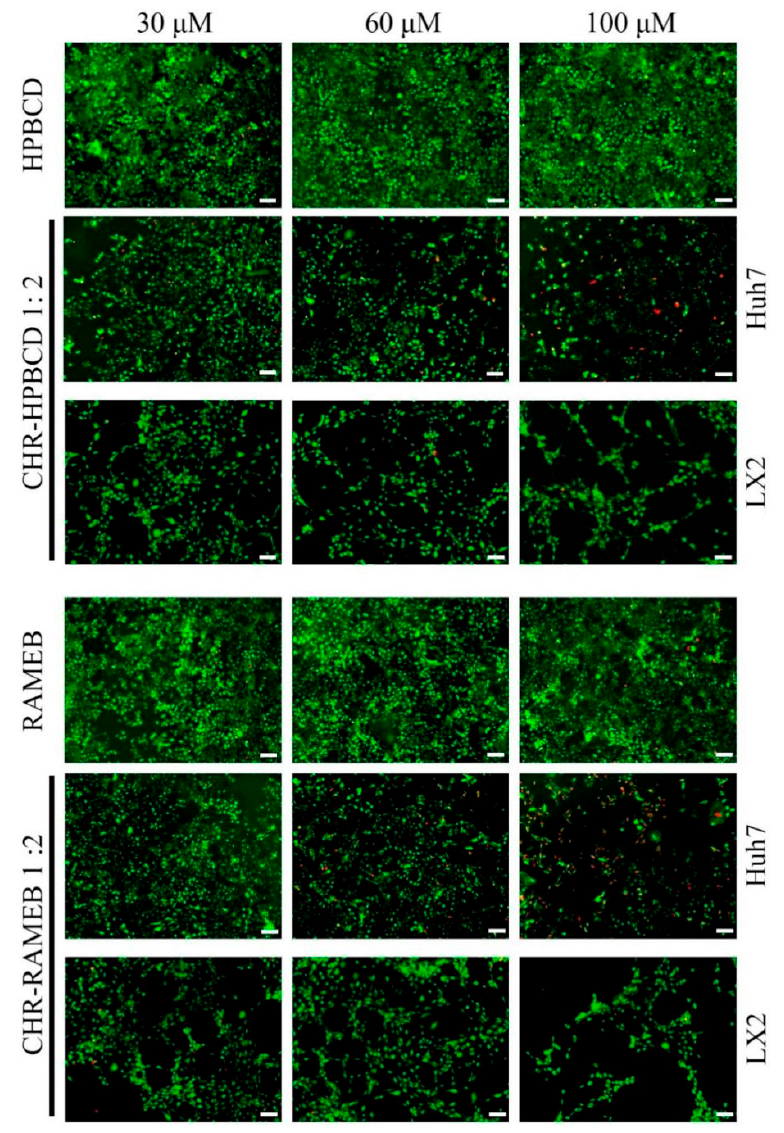
Figure 3. Qualitative LiveDead analysis displaying live cells (green) and nuclei of dead cells (red) of Huh7 and LX2 cells exposed to CDs (RAMEB and HPBCD) and CHR complexes (30, 60, 100 µM). Scale bar 100 µm.